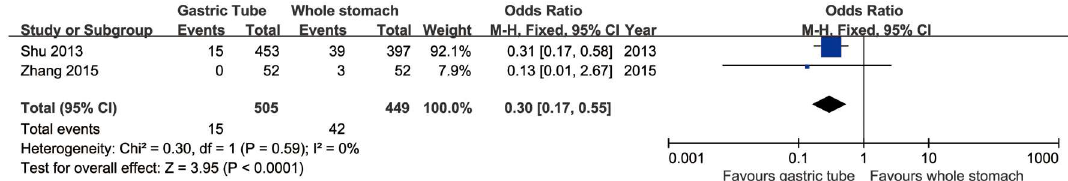
Fig 7. Forest plot of thoracic stomach syndrome in the whole-stomach and gastric-tube